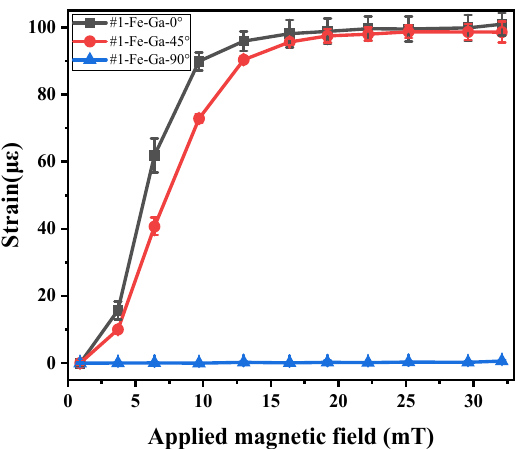
Figure 4. The #1-Fe-Ga sensor response changes with the angle between the sensor axis and the applied magnetic field.